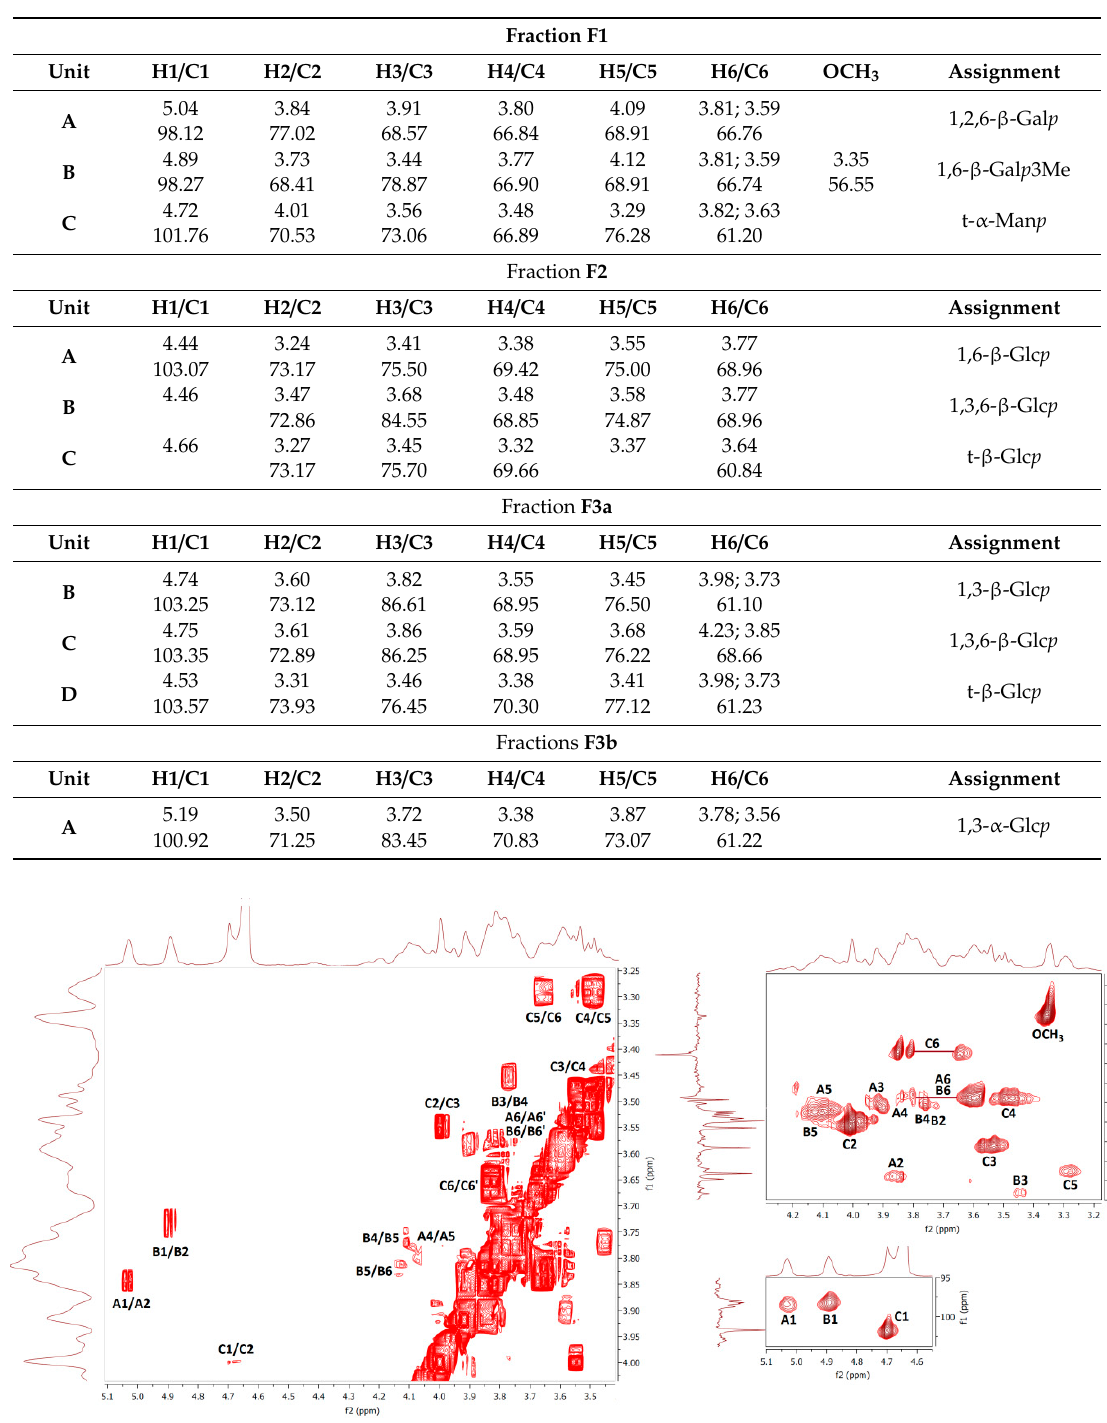
Figure 3. The 1 H, 1 H COSY (left) and 1 H, 13 C HMQC (right) spectra of fraction F1 .